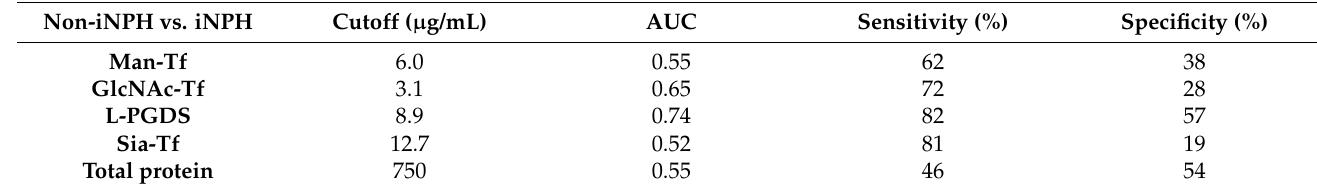
Table 8. Diagnostic accuracy for differentiating iNPH from non-iNPH.